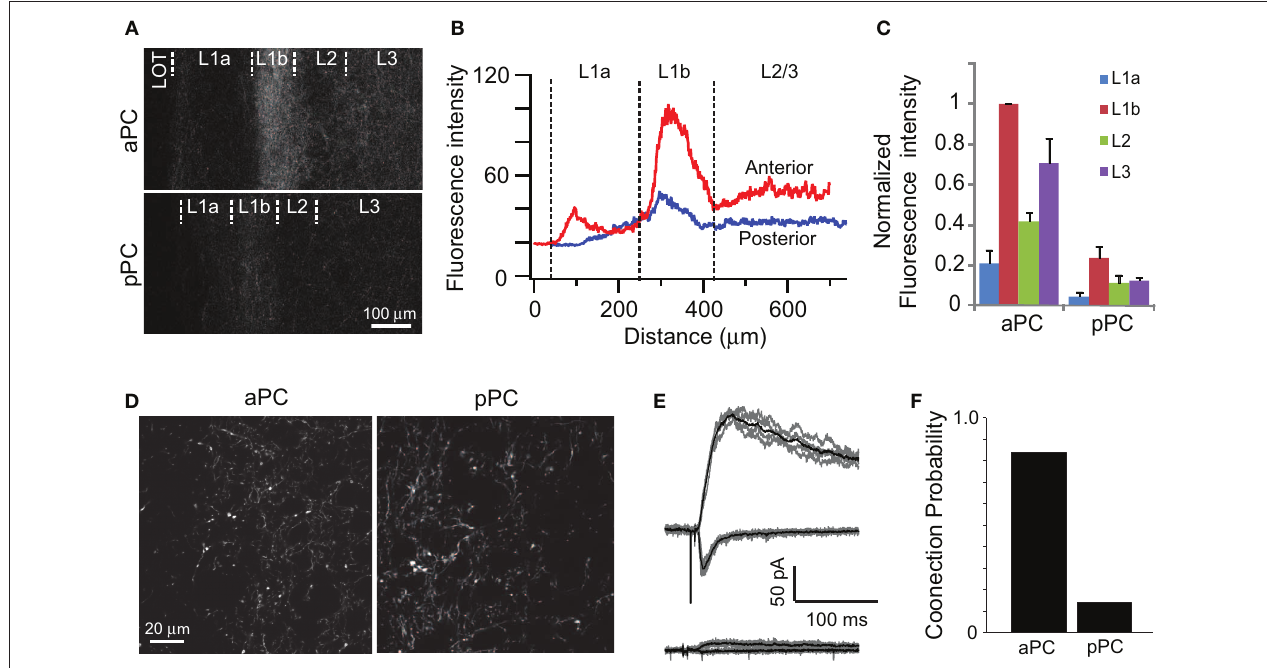
always high in layer 1b and reduced to 40% or less in the pPC. Error bars are SEM. (D–F) Comparison of AON projections to aPC and pPC. Measurements of EYFP fluorescence in layer 1b in the aPC and pPC indicated that the single axon/varicosity fluorescence was not different. However, whole-cell patch-clamp recordings in the pPC rarely revealed large synaptic responses ( E , top) and mostly very small or no current ( E , bottom). The probability was reduced to 0.22 in pPC compared to 0.84 in the aPC (F)